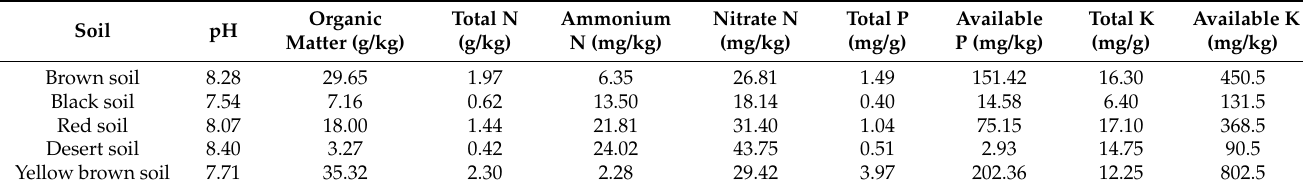
Table 4. The physicochemical properties of different types of soils.